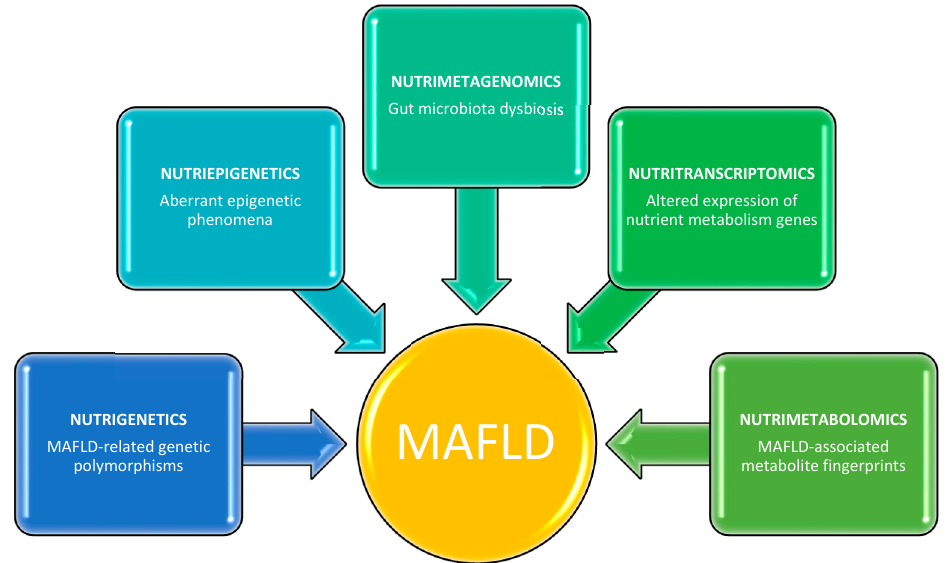
Figure 1. Multi-omics nutritional approaches for identifying potential targets involved in the path- ogenesis of MAFLD.